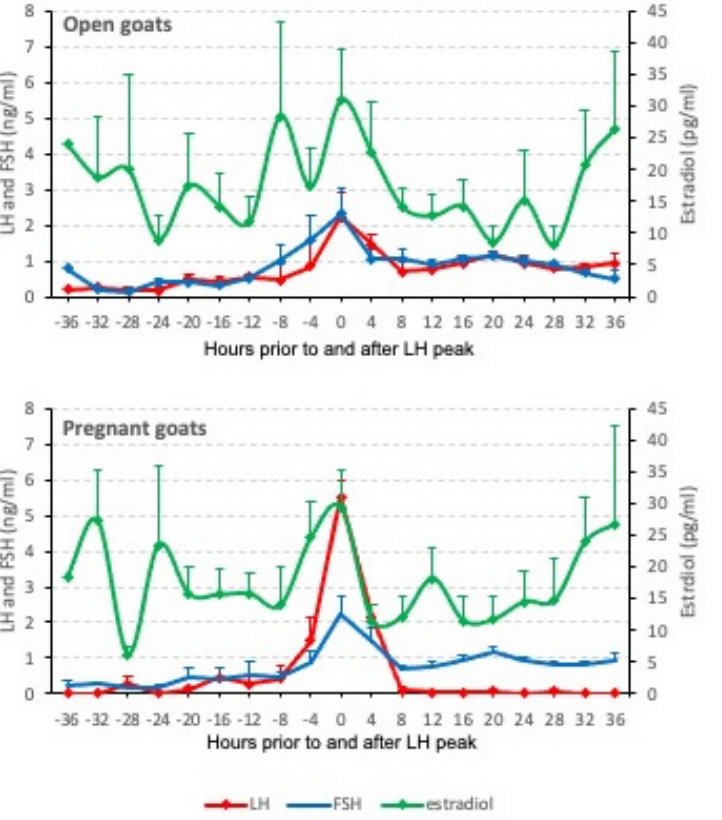
Figure 2. Hormone profiles for LH, FSH and estradiol adjusted to the moment of LH peak in pregnant and open goats. Mean and standard error are shown.